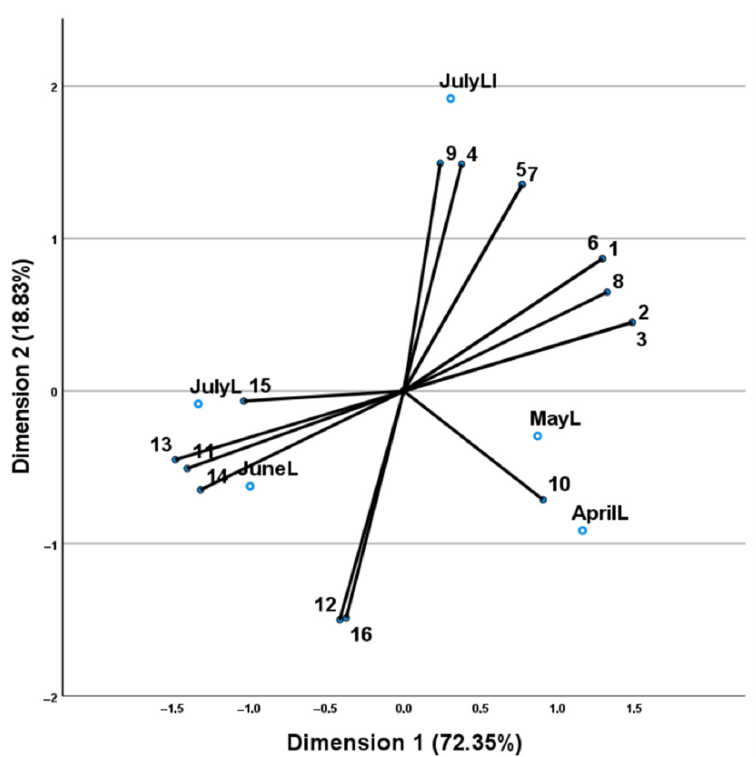
Figure 4. CATPCA analysis based on the chemical composition of S. rosmarinus leaf and inflorescences’ essential oils. Distribution of samples (coding the collection months followed by L for leaves’ tissue and LI for leaves and inflorescences) based on the distribution of variables (numbers of which correspond to those of Table 3), indicates a clear separation of the leaves’ samples collected in the spring months (April, May) from those collected during the summer (June, July), in the first-dimension axis.